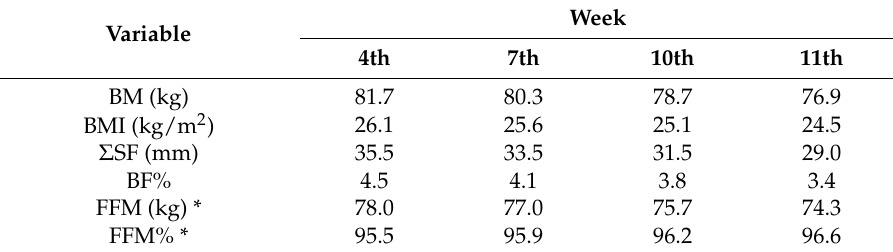
Table 4. Body composition variation during 11 weeks’ AAS